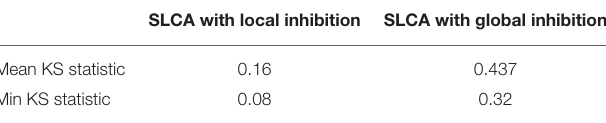
TABLE 1 | KS statistics for SLCA with global and local inhibition.